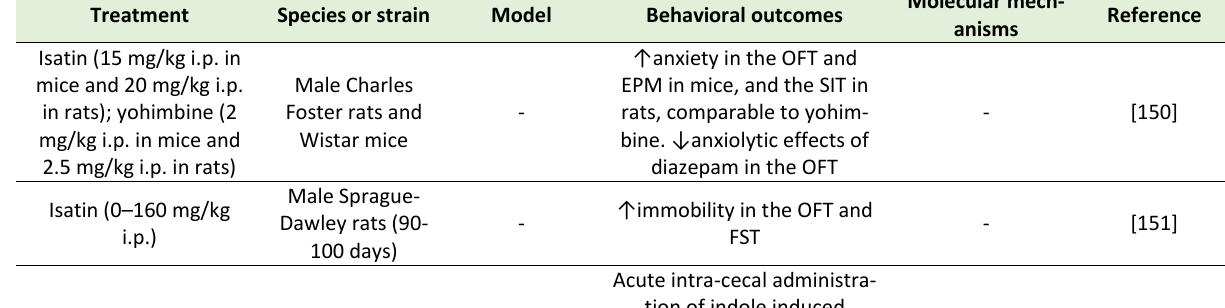
TABLE 4. Studies investigating the effects of indole metabolites on depressive-like behavior.